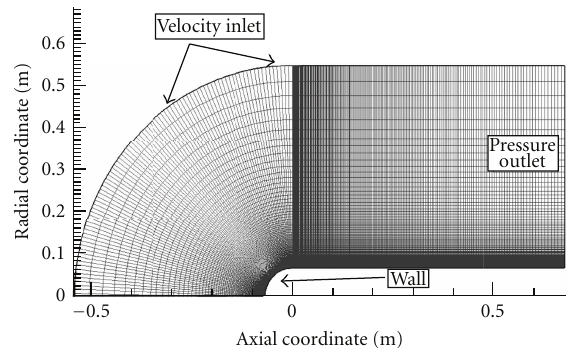
Figure 3: Computational domain and boundary conditions for hemispherical fore-body.